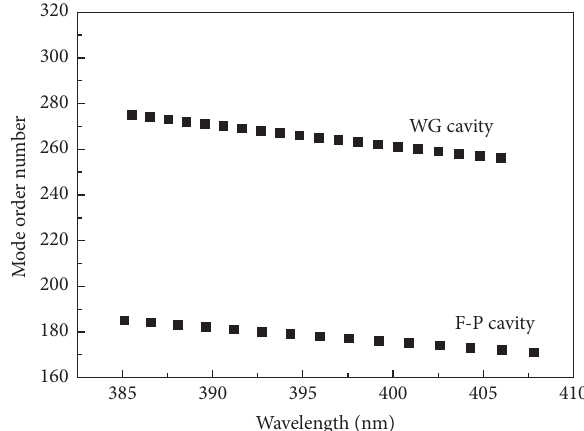
Figure 3: The calculation curve of mode order number versus wavelength in the case of F-P and WG